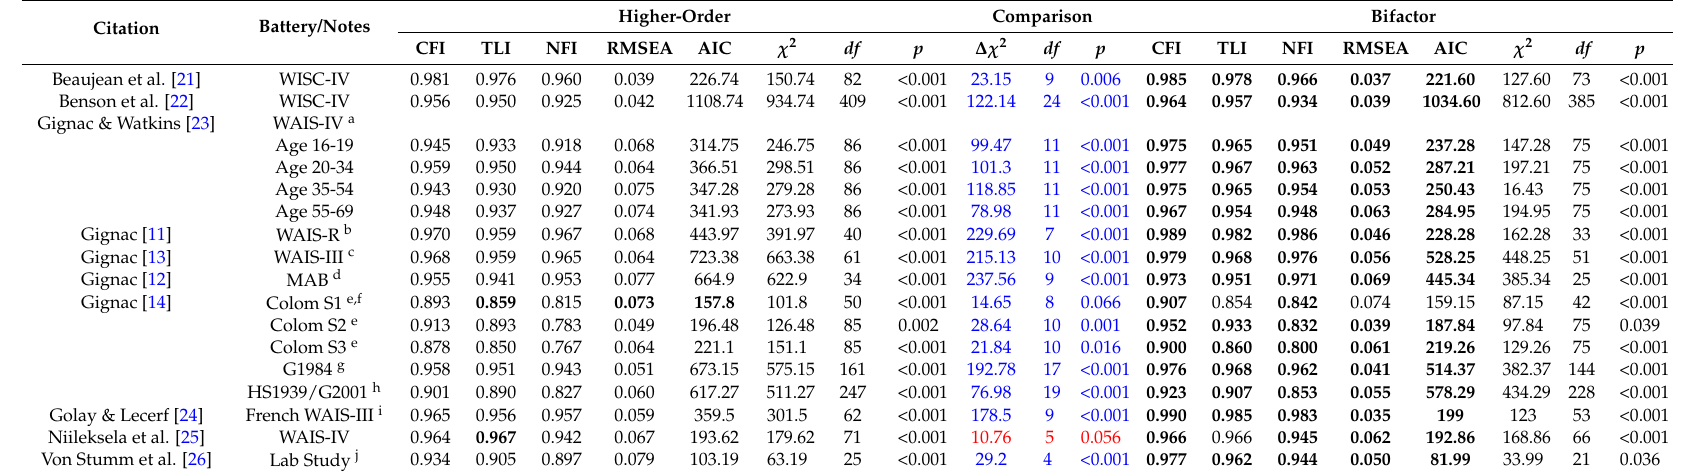
Table 1. Summary of Fit Statistics from Past Bifactor